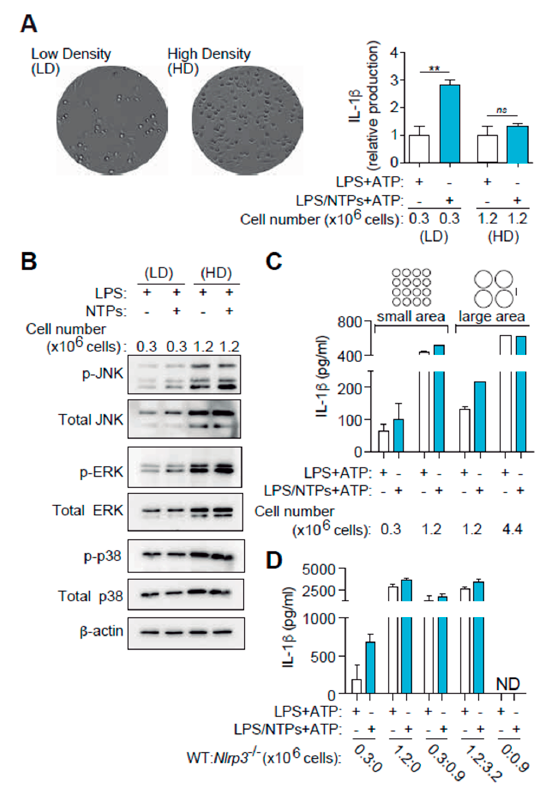
Figure 6. High cell density induces and increase in basal MAPK signaling overriding nucleotide effect on IL-1 β production. ( A ) Differential interference contrast (DIC) images from cells plated at low density (LD, left side) or high density (HD, right) on a p24 well plate and stimulated for 2 h with LPS. Graph on the right shows the average of seven experiments + SEM of IL-1 β detected by ELISA in supernatants from peritoneal macrophages (RPMs) plated at the indicated concentrations and LPS-primed with (blue bars) or without (white bars) NTPs (20 µ M UTP / ATP) for 3 h and then NLRP3 was activated with 3 mM ATP (right plot). Data is normalized to LPS values (white bars). Average of 9 experiments + SEM is shown. ( B ) Western blot for MAPK in RPMs lysates plated at LD or HD and stimulated for 25 min with LPS alone or with NTPs as indicated. One experiment out of two is shown. ( C ) IL-1 β ELISA in RPMs supernatants plated at LD or HD in p96 plate (small area) or p24 plate wells (large area) and stimulated as in ( A ); a representative experiment out of three is shown + SD. ( D ) RPMs from wild-type mice were plated in wells of the same area size at LD or HD. RPMs from NLRP3-deficient mice were used to complement confluence as in HD (third column pair) or in saturated conditions (fourth column